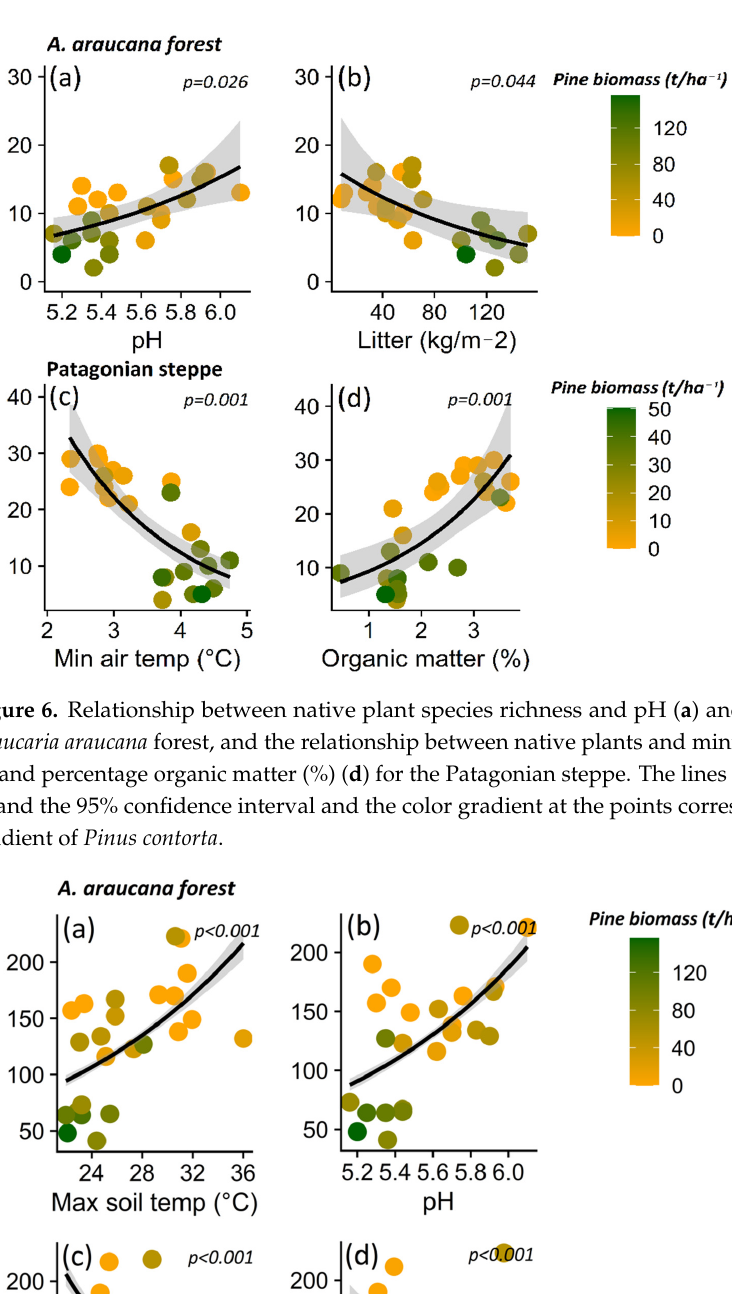
content ( p < 0.001) (Table S5; Figure 8c) and PAR light ( p = 0.008) (Table S5; Figure 8d).